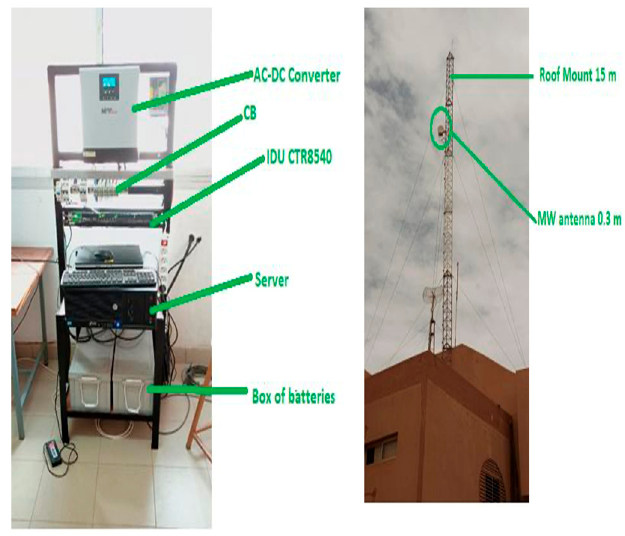
Figure 3. Acquisition system installed at the LA.M.E.